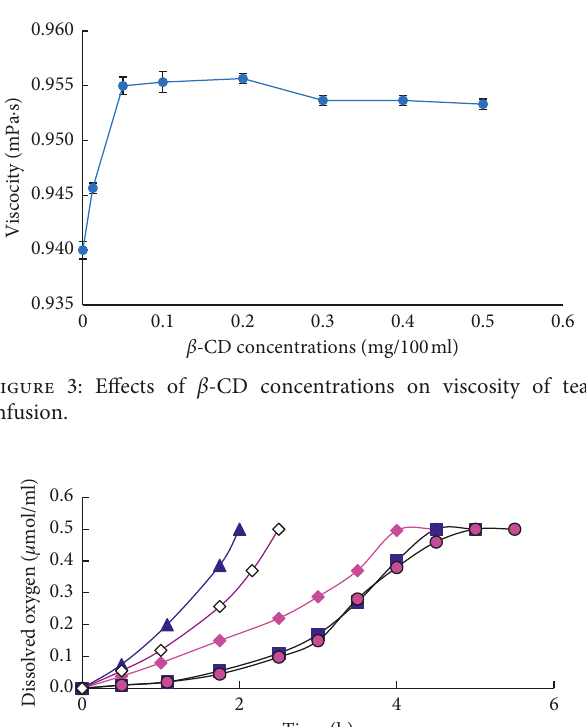
”is 0% β -CD; solid line with “ ” is 0.05% β -CD; solid line with “ ▲ ◆